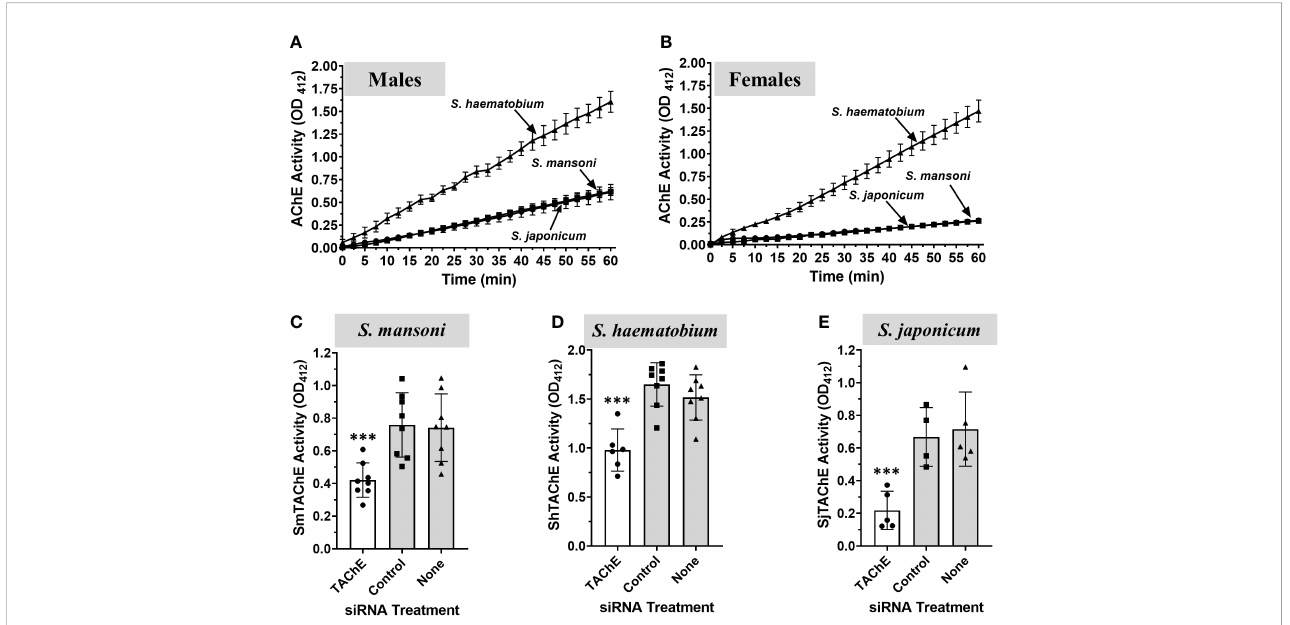
FIGURE 9 Surface AChE activity (mean OD 412 ± SD) in live individual adults of the three medically most important schistosome species S. mansoni , S. haematobium and S. japonicum , as indicated (n ≥ 5). (A) Live individual adult male parasites. (B) Live individual adult female parasites. S. haematobium parasites (both male and female) exhibit signi fi cantly higher surface AChE activity versus S. mansoni or S. japonicum parasites (p < 0.001, Two-Way ANOVA). No signi fi cant difference is observed between live S. mansoni and S. japonicum adult parasite AChE activity. (C – E) A universal siRNA targeting the tegumental AChE gene of the three species was designed and used to knock-down the expression of this gene in adult male parasites. Seven days later the surface AChE activity (mean OD 412 ± SD) was measured in live, gene-suppressed versus control S. mansoni (C) , S. haematobium (D) or S. japonicum (E) adult males. Each point represents the data from one worm, and the line represents the mean ( ± SD) for the group. In all cases, gene suppression resulted is signi fi cant reductions in surface AChE activity ( C , S. mansoni; ***p < 0.001), ( D , S. haematobium ; ***p < 0.0001) and ( E , S. japonicum ; ***p < 0.008, all by ANOVA). Values obtained at 60 min are